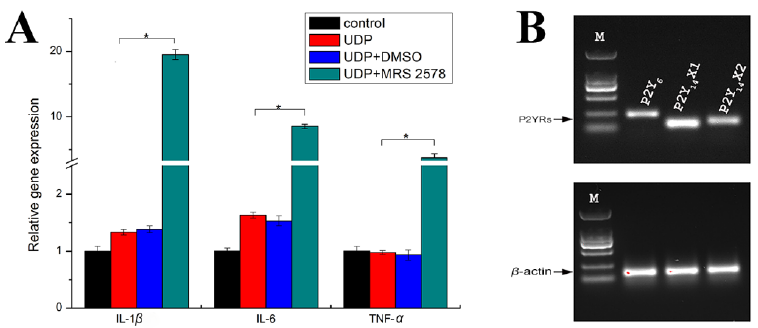
Figure 5. P2Y 6 receptor mediates pro ‐ inflammatory cytokine gene expression in Japanese flounder PBL cells stimulated with uridine 5 ′‐ diphosphate (UDP). ( A ) Inhibition of P2Y 6 receptors